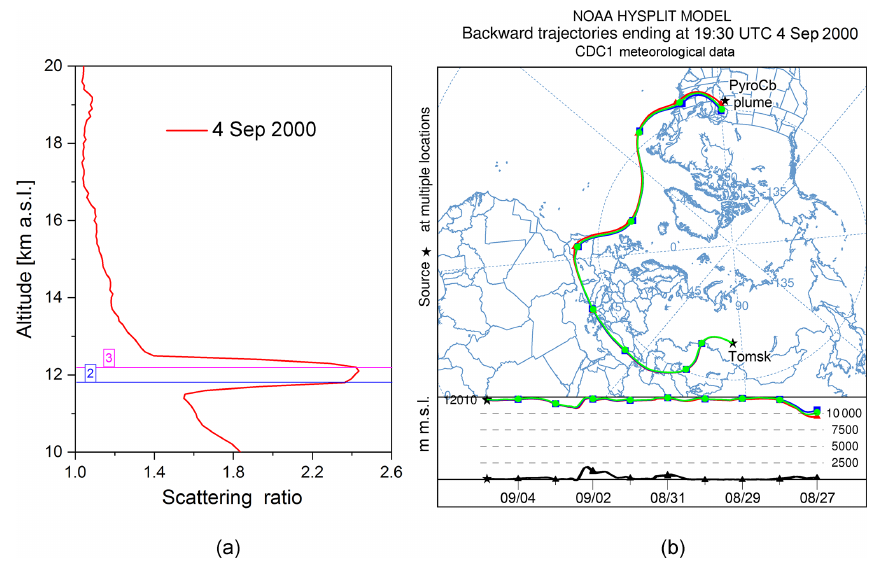
Figure 2. (a) Detection of the Jasper Fire pyroCb plume in the UTLS over Tomsk. The numbers 2 and 3 indicate the tropopause altitudes estimated in Emeljanovo and Novosibirsk, respectively, at 19:30UTC on 4 September 2000. (b) Air mass backward ensemble trajectories started from altitudes of 12.0–12.15km over Tomsk at the same